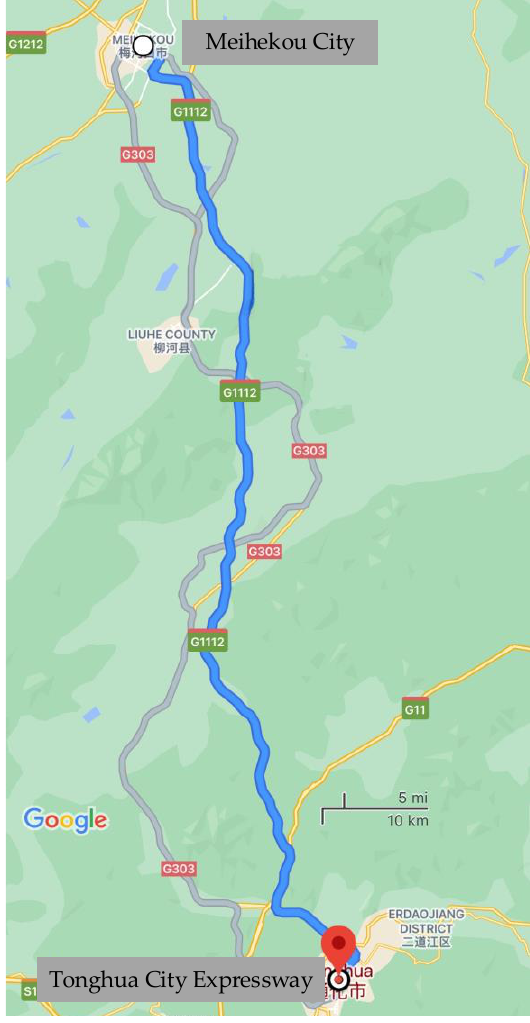
Figure 4. Experimental Roadmap.